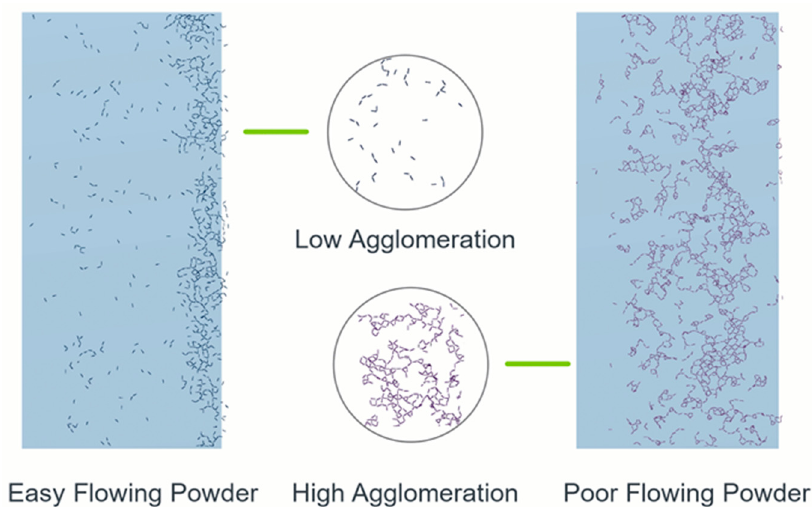
Figure 8. Mass flow rate for the free-flowing (blue) and the cohesive (orange) materials.